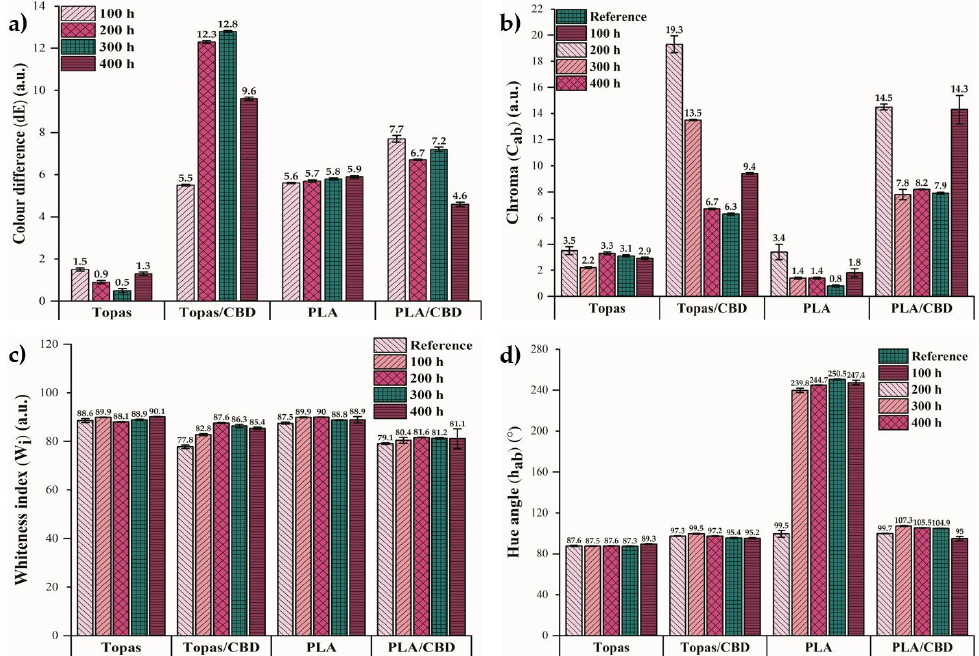
Figure 5. Optical properties of ethylene-norbornene copolymer (Topas) and polylactide (PLA) blends: ( a ) color difference (dE), ( b ) chroma (C ab ), ( c ) whiteness index (W i ), ( d ) hue angle (h ab ) before and after 100, 200, 300, and 400 h of weathering. Presented values are the average of three measurements.